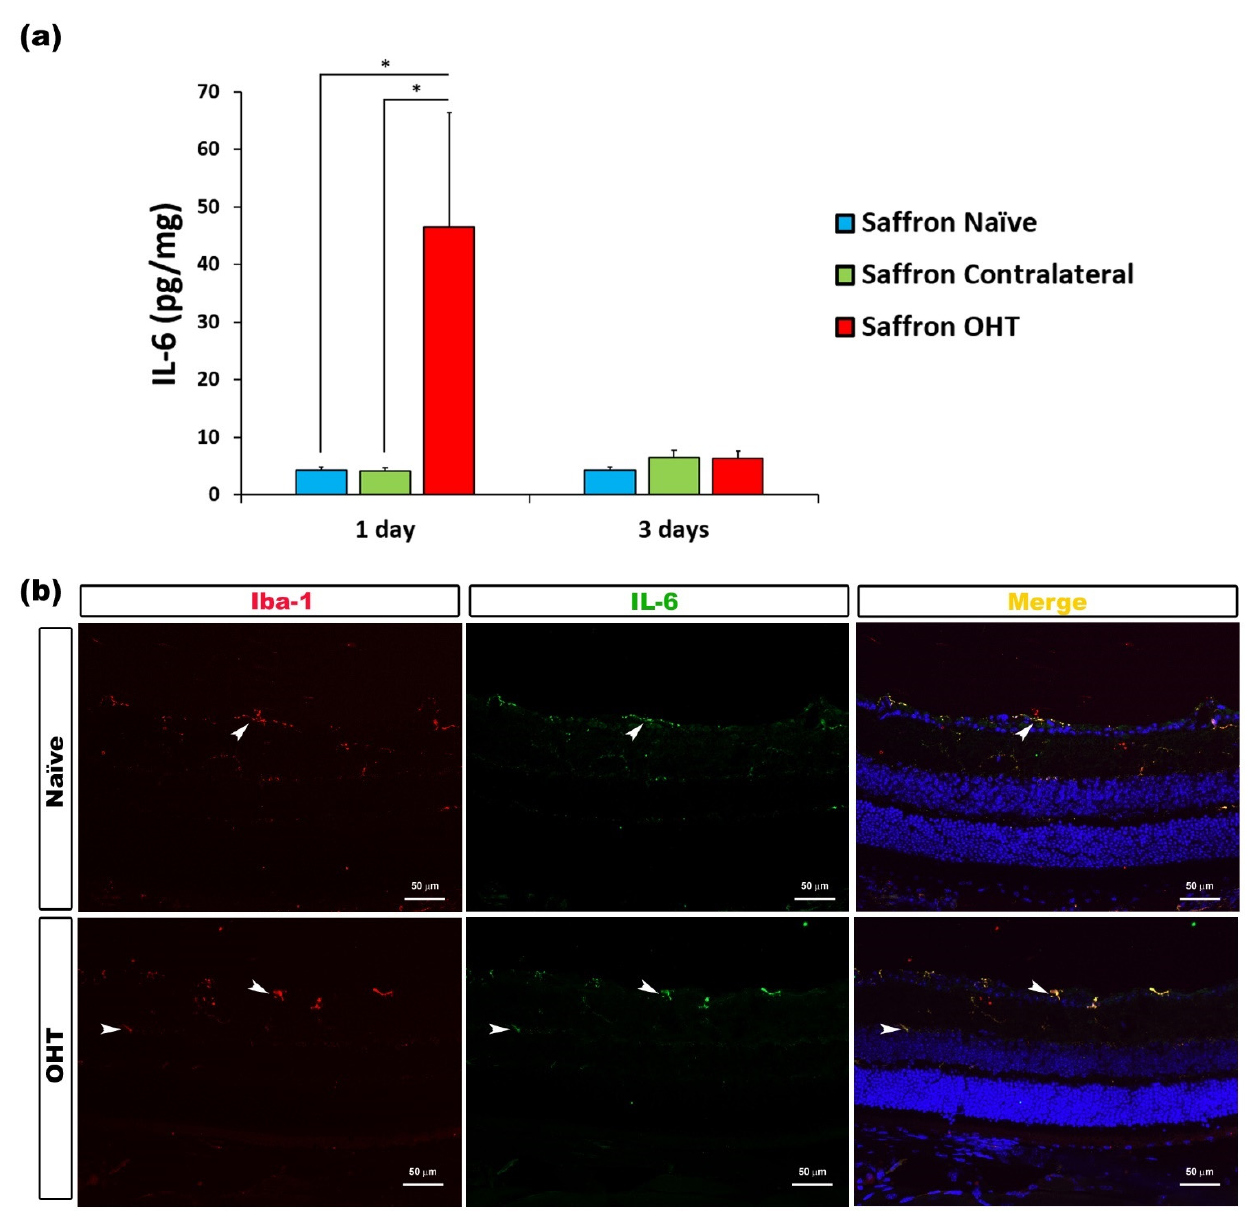
Figure 3. IL-6 levels at 1 and 3 days after laser-induced ocular hypertension (OHT). ( a ) The IL-6 values obtained in the multiplex assay. The histogram shows the mean levels (±SD) of IL-6 (pg/mg) at days 1 and 3 after laser OHT induction in saffron ocular hypertension eyes (saffron OHT), saffron-contralateral eyes (saffron-contralateral), and saffron-naïve eyes. Statistical significance indicators: * p < 0.05. ( b ) Immunohistochemical study of IL-6 expression in saffron OHT eyes one day after unilateral laser-induced OHT. Retinal sections were immunolabeled with antibodies to IL-6 (green) and Iba-1 (red). Merge is denoted by the colour yellow. The arrowhead shows the co-expression of Iba-1 and IL-6 in saffron OHT and saffron-naïve eyes. Abbreviations: OHT (ocular hypertension); IL-6 (interleukin 6); Iba-1 (ionized calcium-binding adaptor molecule).